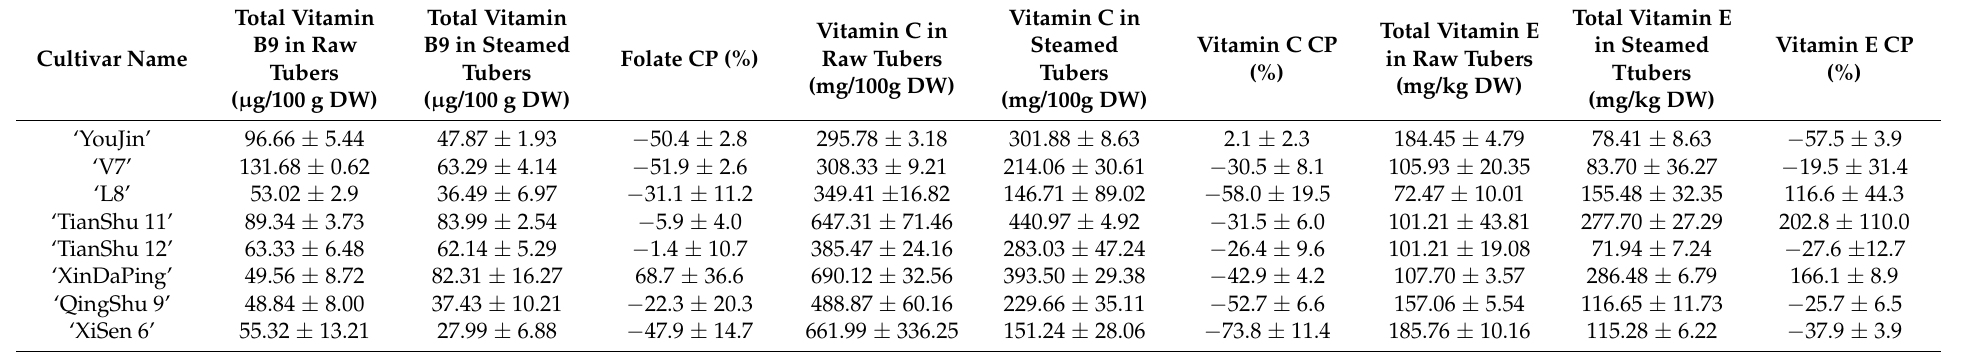
Table 5. The content of total vitamin B9, vitamin C, and vitamin E among raw and steamed tubers of potato cultivars on a dry-weight